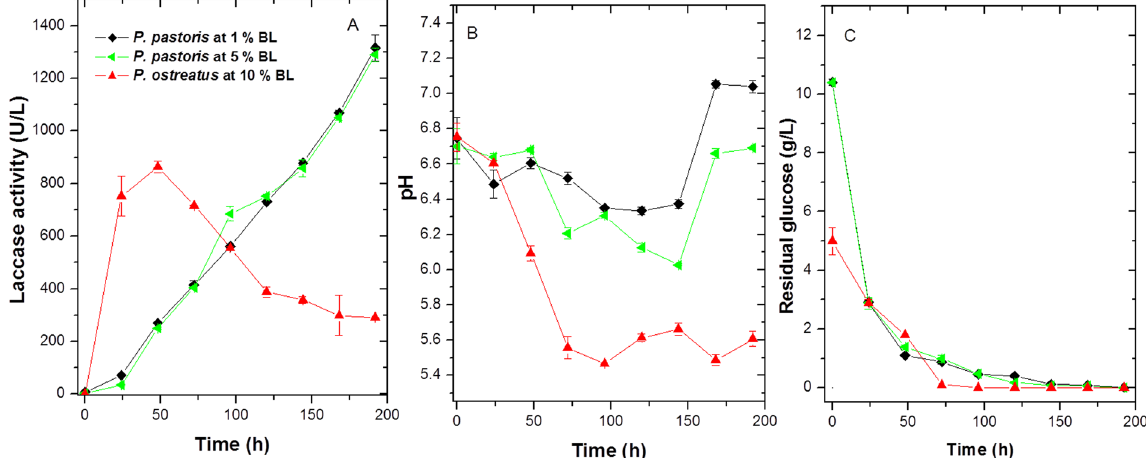
Figure 4. ( A ) Laccase activity, ( B ) pH, and ( C ) residual glucose for P. ostreatus in 10% (v/v) SBL and P. pastoris in 1% and 5% (v/v) SBL. The laccase activity depended on the microorganism. The removal curves for P. ostreatus showed an increase in activity during the first 48 h, reaching a maximum value of 862 UL − 1 , followed by a decrease at 192 h with an activity of 290 UL − 1 . In contrast, the constitutive expression regulated by the laccase p GAP promoter enzyme was constant in the P. pastoris removal curves for both SBL concentrations, with activities of 1,346 and 1,327 UL − 1 for 5 and 1% SBL, respectively. Regarding glucose consumption and pH variability, both fungi gradually consumed the carbon source, generating a decrease in pH attributed to organic acid production. The results are presented as the mean ± SD (n =